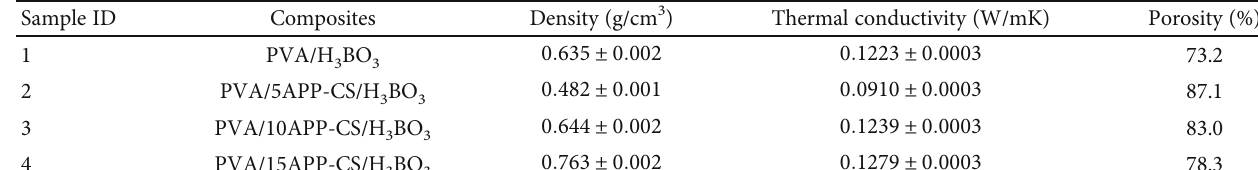
Table 1: Density, thermal conductivity, and porosity of the PVA composite